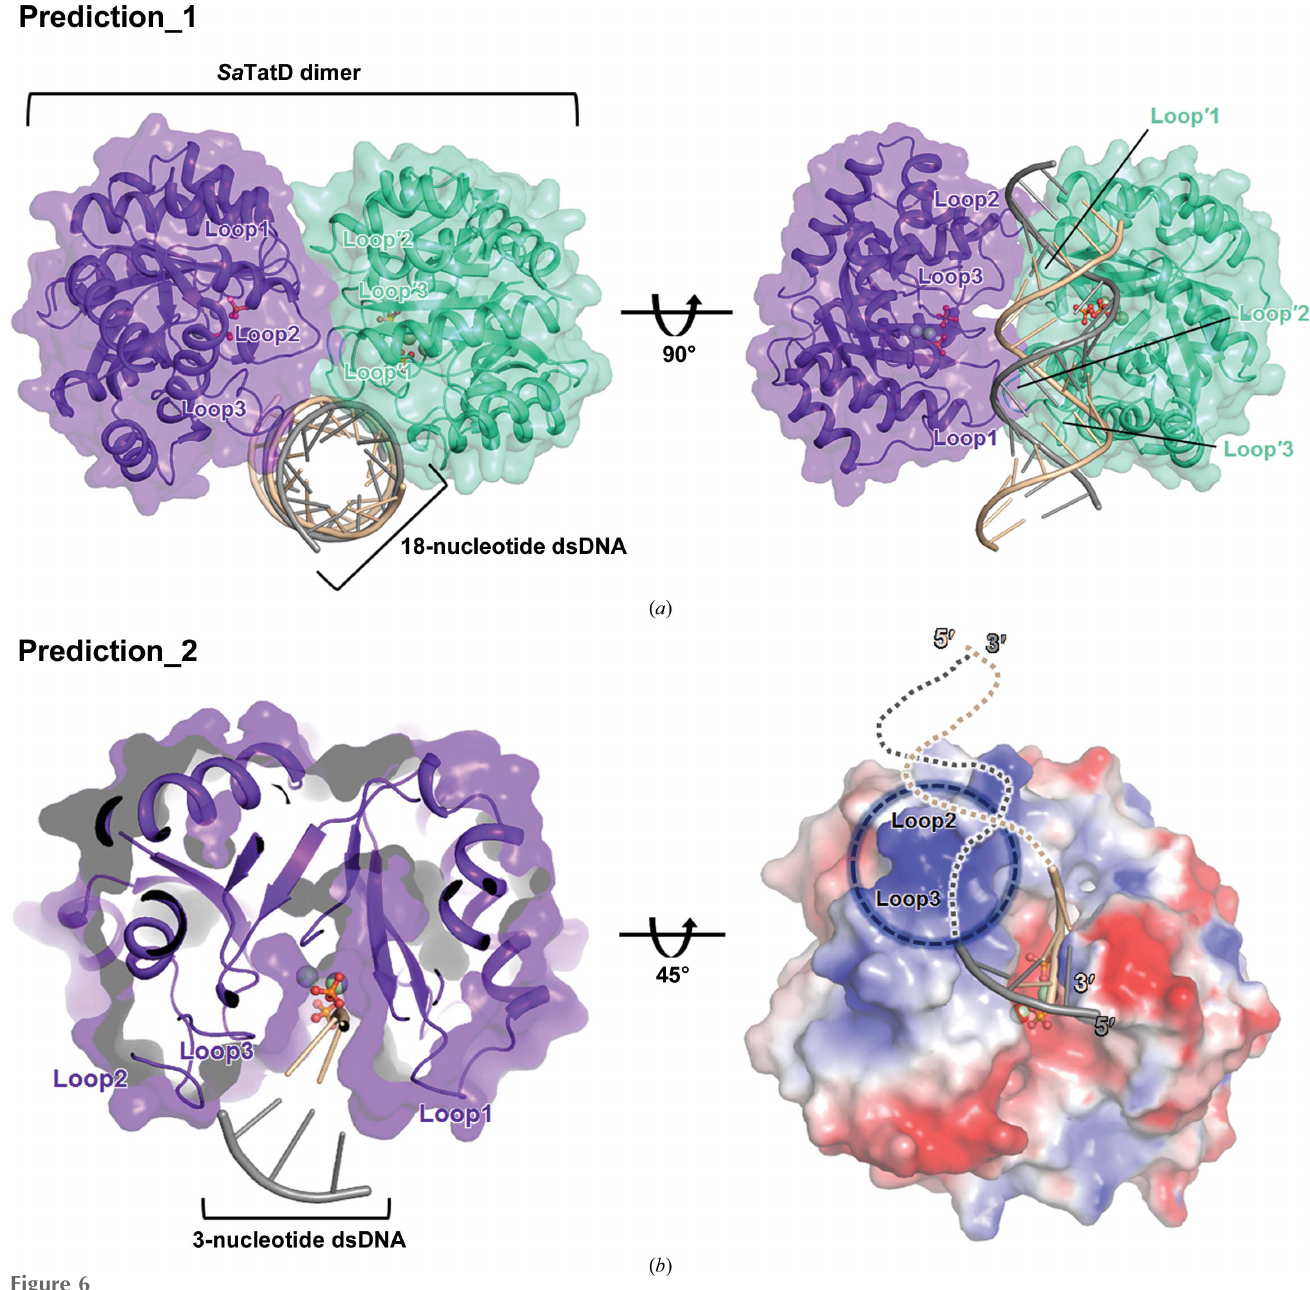
Figure 6 Proposed DNA-binding mode. ( a ) Prediction_1 for the DNA-binding mode of the Sa TatD dimer with 18-mer dsDNA. Prediction_1 suggests that owing to the dimeric interface, DNA has difficulty approaching the active site of Sa TatD. DNA is shown as a ribbon diagram, and the DNA strands are colored wheat (3 0 –5 0 ) and dark gray (5 0 –3 0 ). ( b ) Prediction_2 for the DNA-binding mode of the Sa TatD monomer with 3-mer dsDNA considering structural hindrance. Elongated DNA chains that may bind to the basic surface area (blue dotted circle) consisting of Loop2–Loop3 are displayed as wheat and dark gray dotted